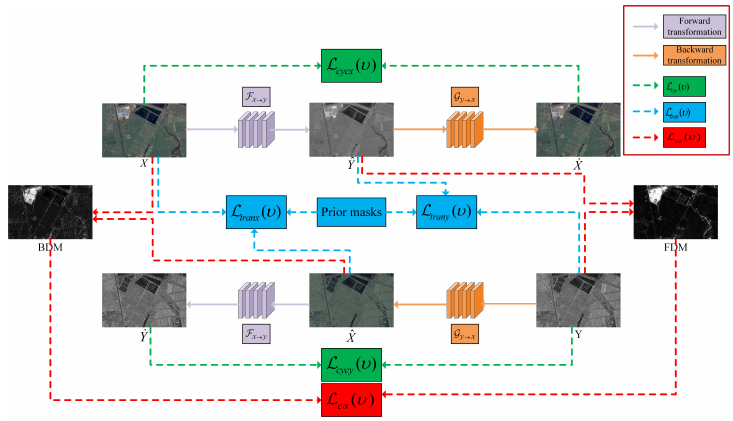
Figure 1. Framework of the proposed